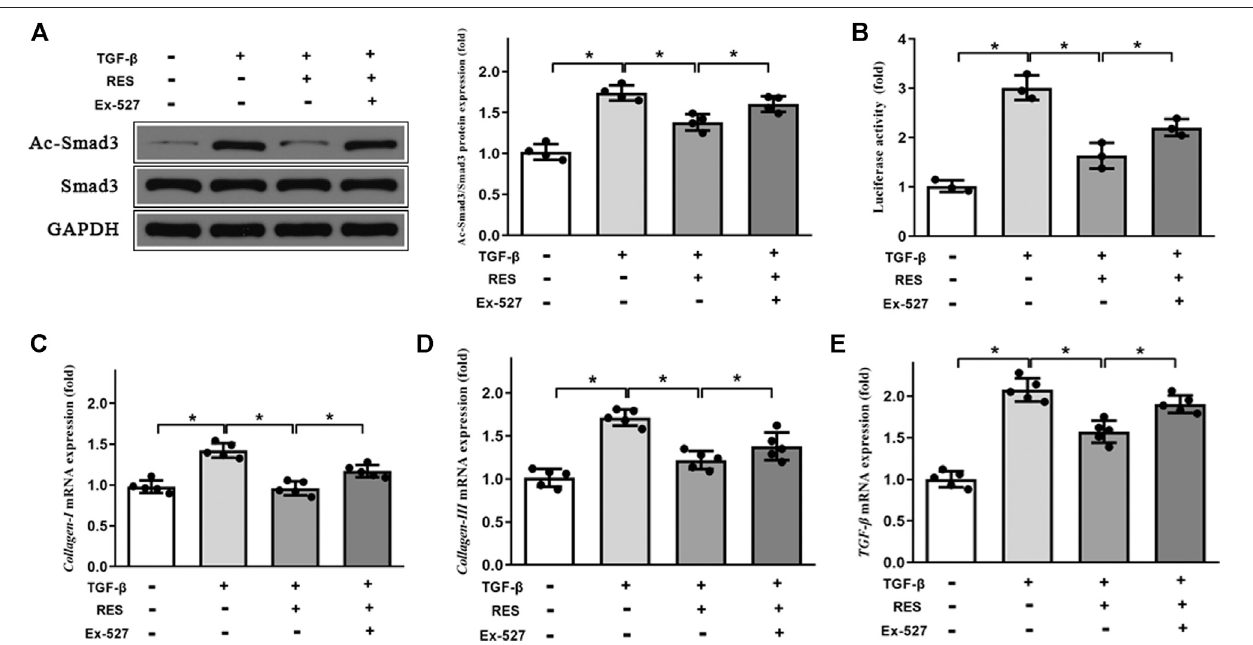
FIGURE 8 | Effect of Sirt1 inhibition on the Smad3 expression and pro- fi brotic markers ’ mRNA expression in CFs. (A) Representative western blots and quantitative results of the Smad3 and Ac-Smad3 proteins in CFs ( n (cid:2) 4 per group). (B) The transcriptional activity of SMAD3 is represented as the intensity of luciferase reporter gene activity( n (cid:2) 3pergroup).QuantitativeresultsofmRNAexpressionofthepro- fi broticmarkers (C) collagen-I , (D) collagen-III ,and (E) TGF- β inCFs( n (cid:2) 5pergroup).** p < 0.05.